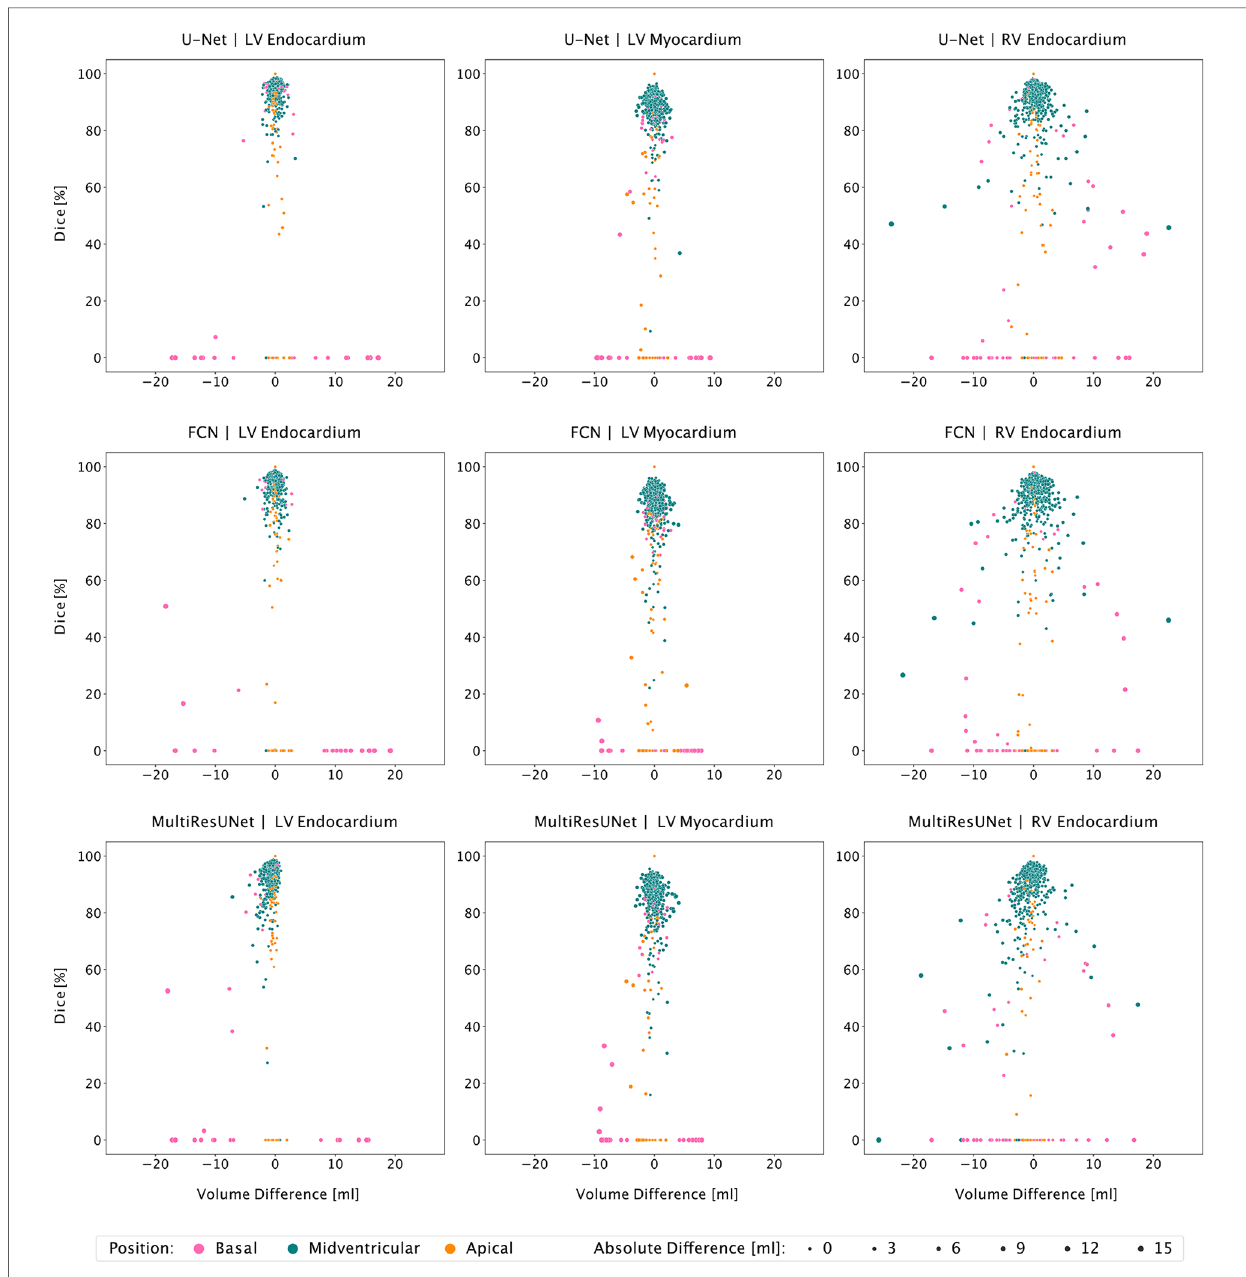
FIGURE 4 Correlation plots of segmentation comparisons according to slice position. Rows identify the network compared to the expert. Columns identify the considered contour type. Points represent contour comparisons characterized by volume difference and Dice value. Color implies the slice